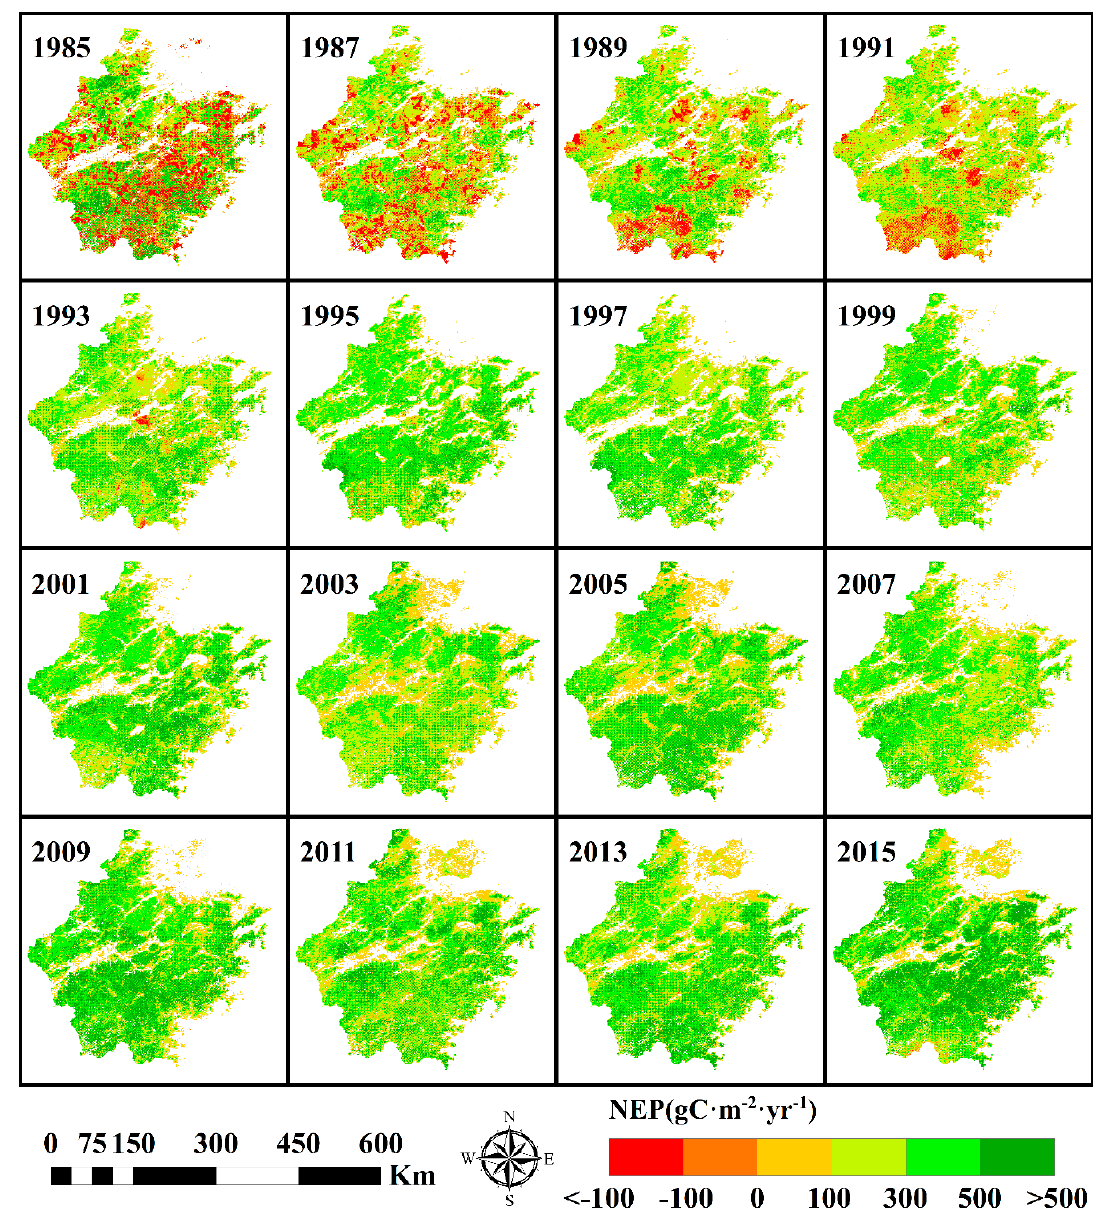
Figure 7. The spatial distribution of forest NEP values in Zhejiang Province during 1985–2015.